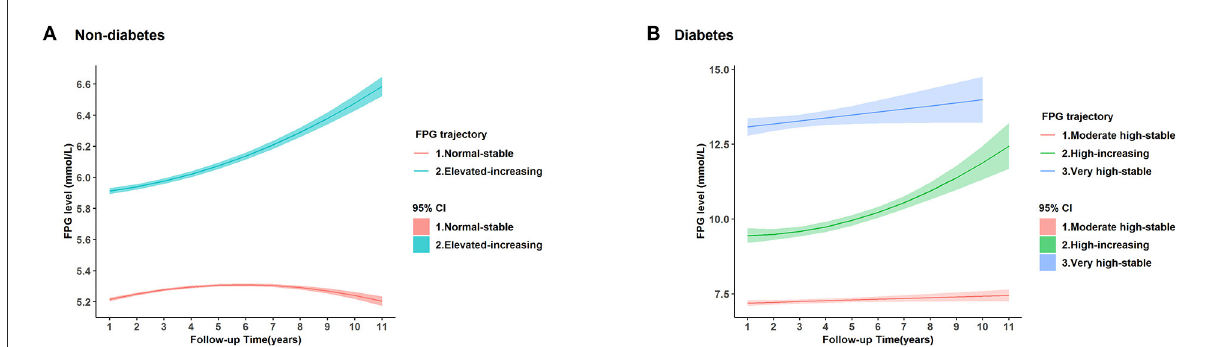
FIGURE2 Trajectories of fasting plasma glucose (FPG) in 18,313 individuals based on the latent group membership. The lines are the trajectory of fasting plasma glucose (FPG) over time in (A) non-diabetic participants and (B) diabetic participants. The shadow was the 95% confidence interval (CI) of each trajectory. We defined that the stable normal level referred to FPG ≤ 5.6 mmol/L, elevated FPG level referred to FPG in 5.7–6.9 mmol/L, moderate-high level referred to FPG in 7.0–8.9 mmol/L, high level of FPG referred to FPG in 9.0–10.9 mmol/L, and very high levels referred to FPG > 11.0